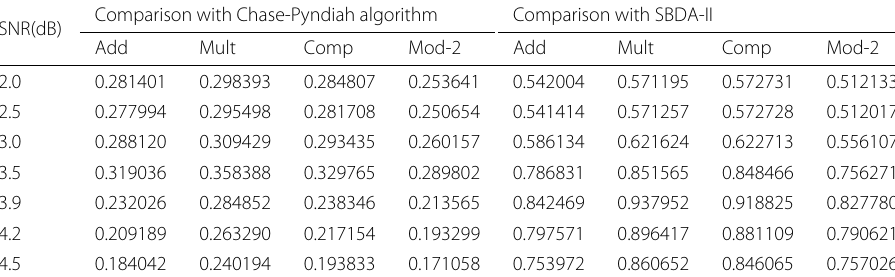
Table 8 The relative complexity result of ( 128, 120, 4 ) 2 TPC for four arithmetic operators on the proposed decoding algorithm when each complexity of Chase-Pyndiah algorithm and SBDA-II are set to 1 (Add: addition, Mult: multiplication, Comp: comparison, Mod-2: